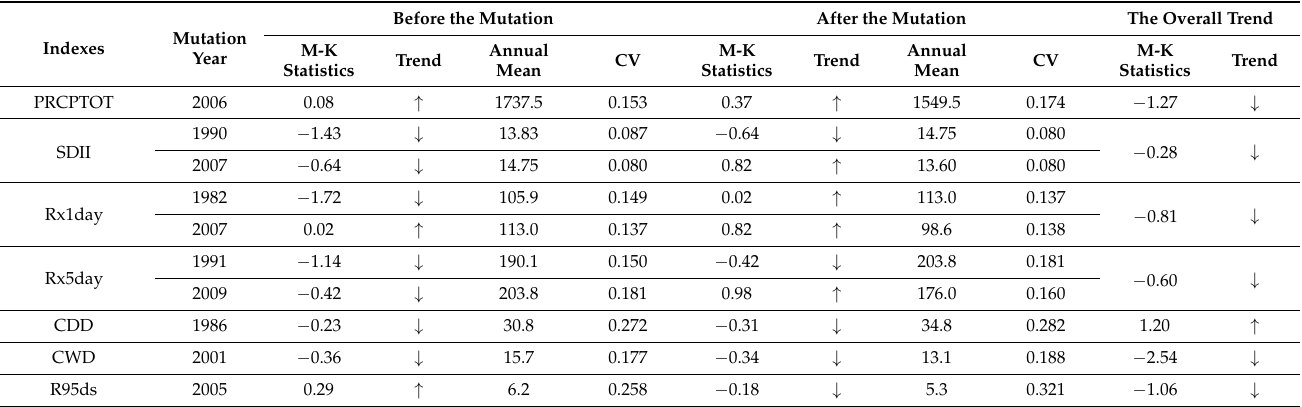
Table 3. Test results of change trend before and after the mutation points.